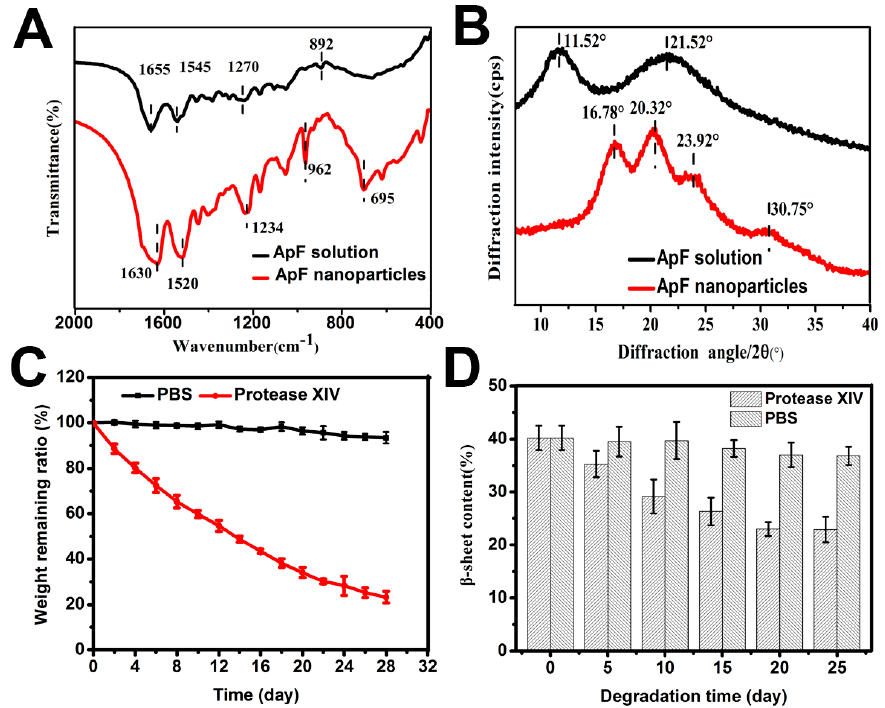
Figure 6. The secondary structure of Ap F nanoparticles and in vitro degradation of Ap F nanoparticles. ( A ) FTIR spectra of Ap F; ( B ) XRD of Ap F; ( C ) In vitro degradation of Ap F nanoparticles shown as percentage degradation over four weeks; and the ( D ) β -sheet content of silk crystals as a function of enzymatic degradation time by protease XIV and PBS denotes the data for the controls, treated by phosphate-buffered solution without enzyme.